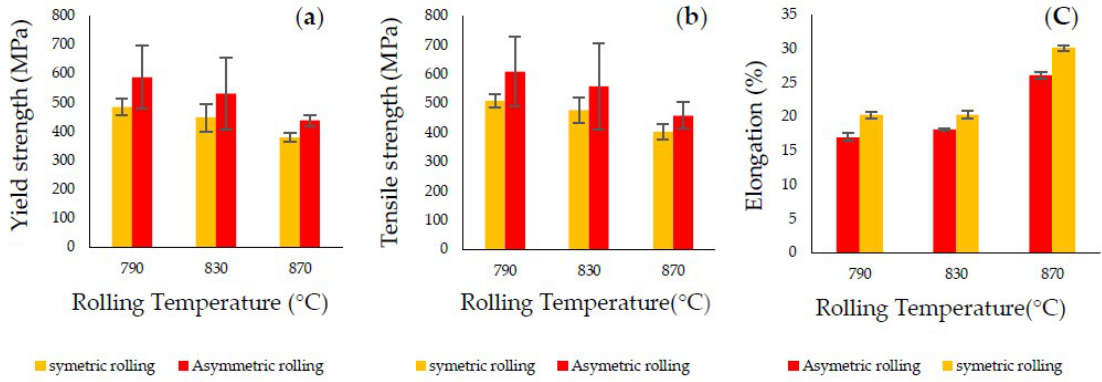
Figure 8. The effect of rolling temperature and rolling speed ratio on ( a ) yield strength values, ( b ) tensile strength values, ( c ) elongation values of warm rolled steels.